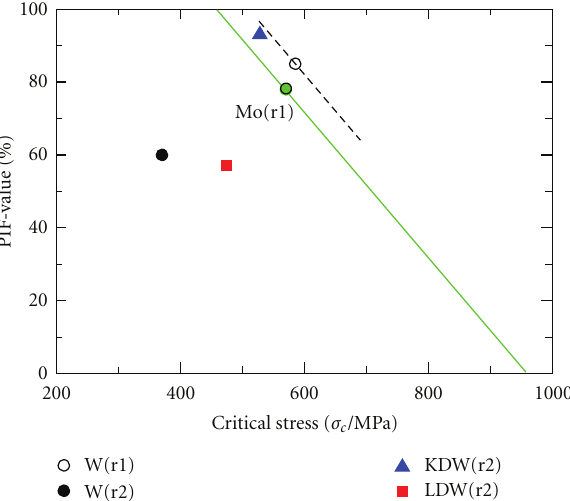
Figure 8: Plots of PIF-value against critical stress for various mate- rials.